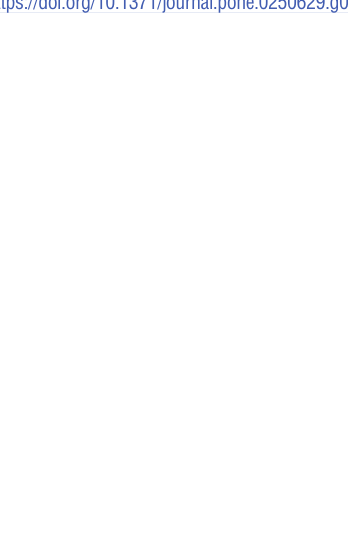
Fig 5. RDA with the first two axes explaining 89.83% of total variance Eigen values of axis 1 = 2.80 and axis 2 = 0.582. DI = Deception island, LI = Livingston island.